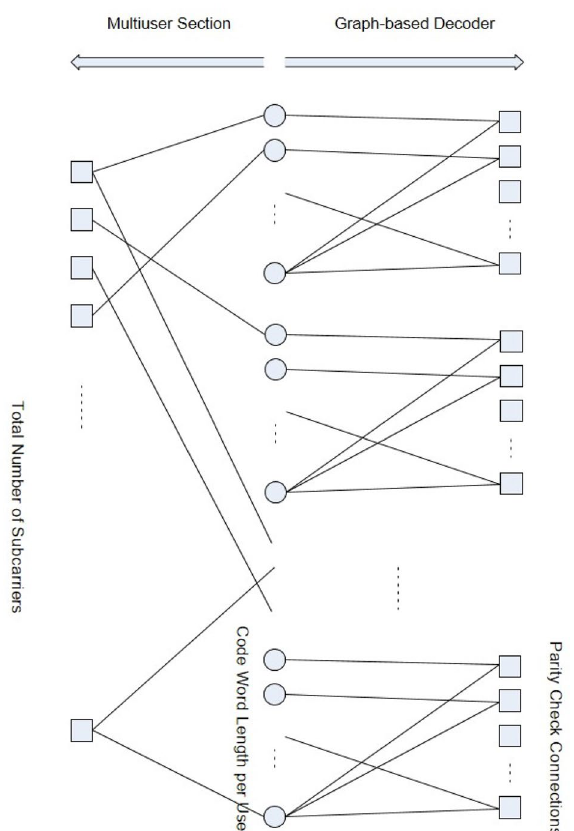
Figure 1. OFDRMA unified graphical